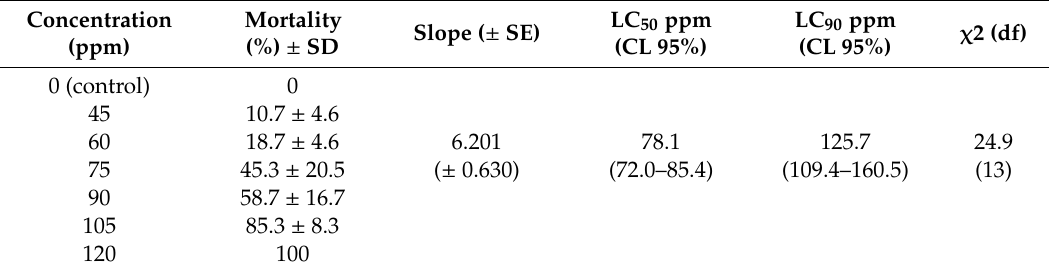
Table 2. Larvicidal activity of Mentha arvensis L. essential oil against Aedes aegypti larvae after 24 h